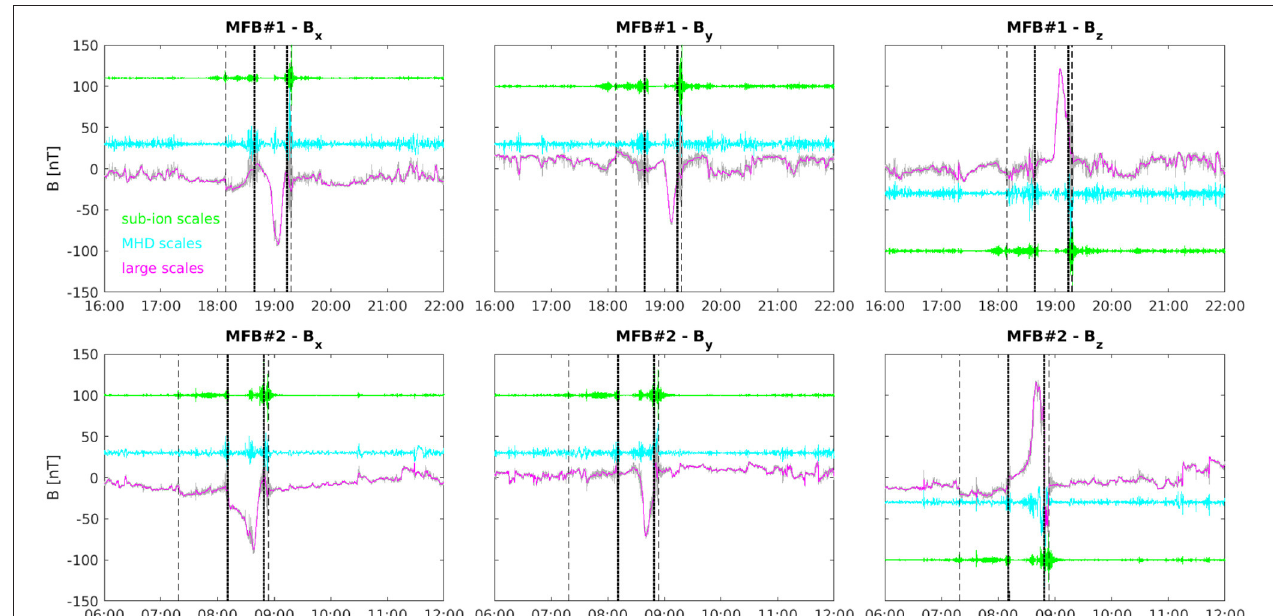
FIGURE 4 | The sub-ion (green), the MHD (cyan), and the large-scale (magenta) reconstructions for each magnetic field component ( B x , B y , and B z , in the left, middle, and right panels) for the first (top) and the second (bottom) Mercury flybys, respectively. The gray line corresponds to the raw data, while the vertical dashed and dotted lines refer to the bow shock and magnetopause crossings, respectively. An offset is applied to the sub-ion and MHD reconstructions for visual